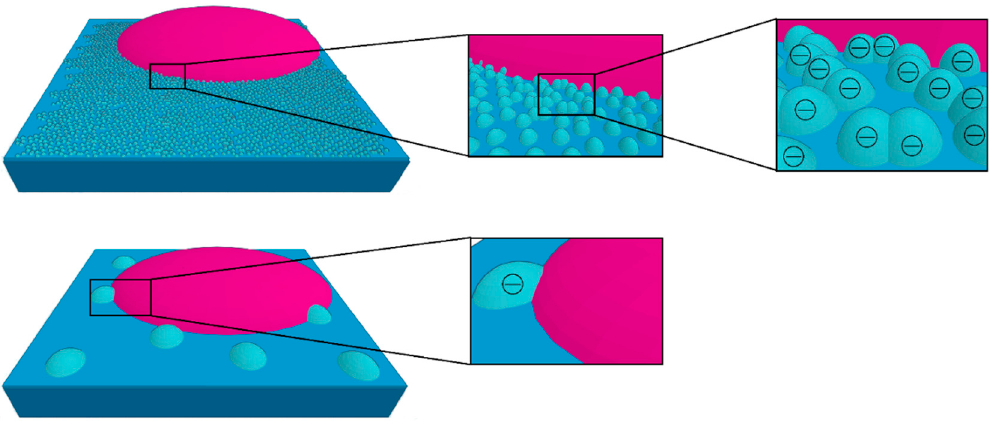
Figure 9. Schematic of 60 nm (upper) and 368 nm (bottom) average diameter silver nanoparticles (AgNPs) deposited onto titanium surfaces, on which cell culture was applied.